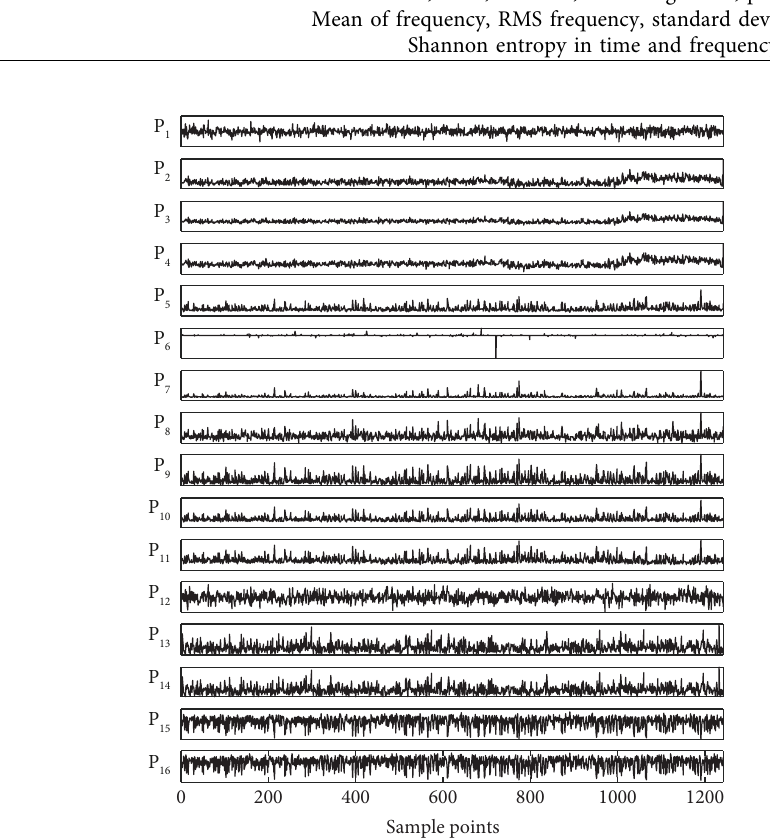
Figure 7: 16-dimensional feature time domain waveform of harmonic